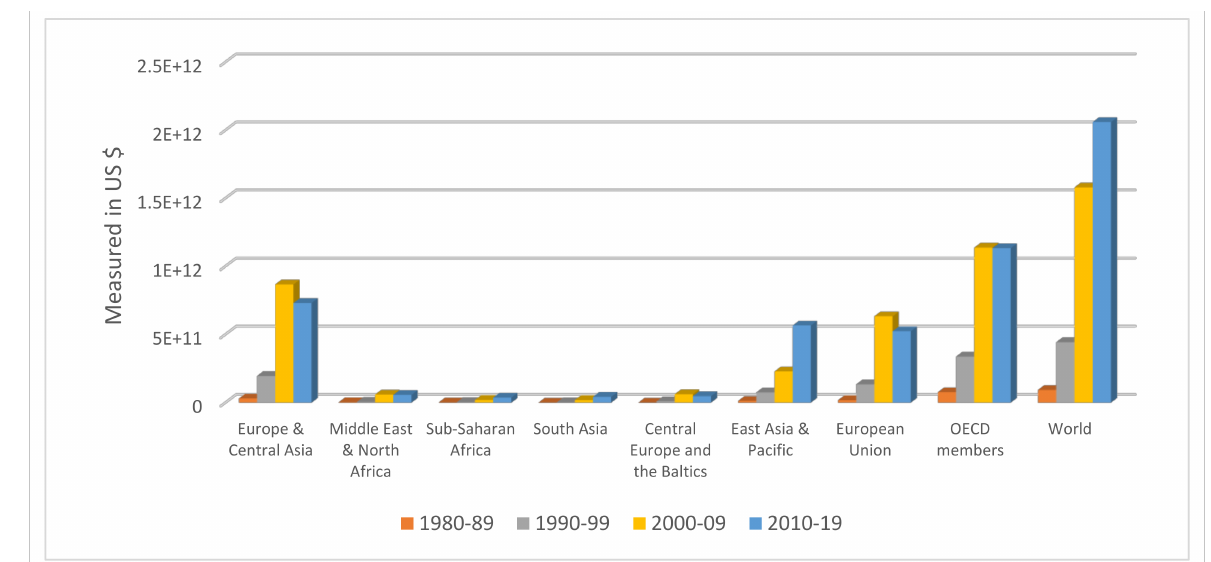
Figure 1. Trend of net FDI inflow across the world regions (in constant US dollars). Source: World Bank Development Indicator Database (2021).